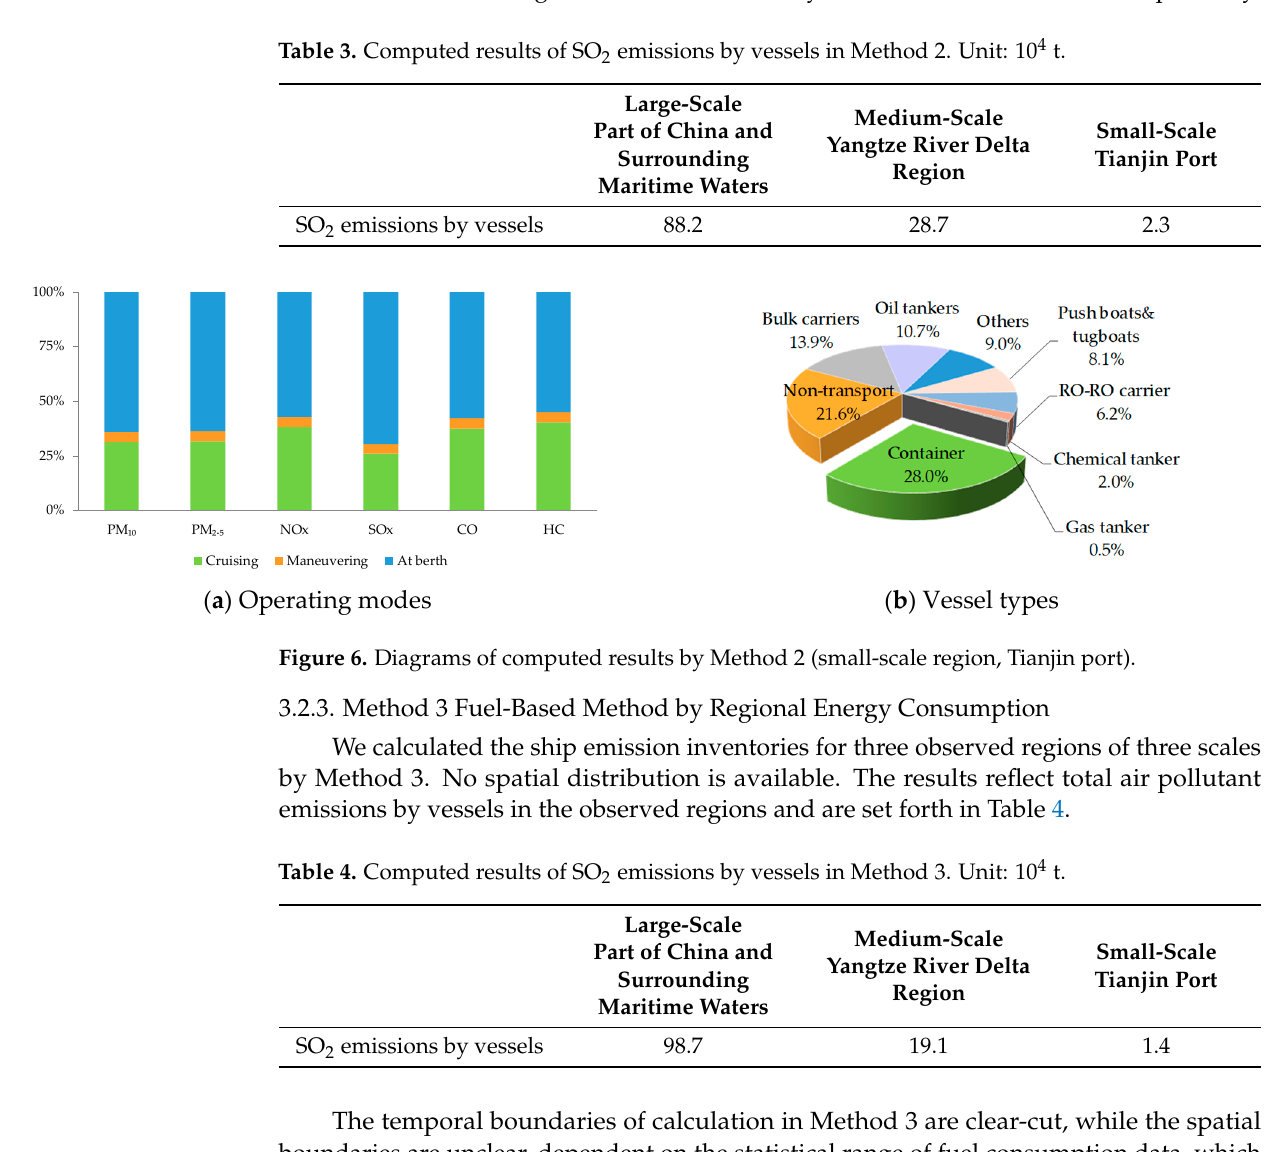
Table 4. Computed results of SO 2 emissions by vessels in Method 3. Unit: 10 4 t.